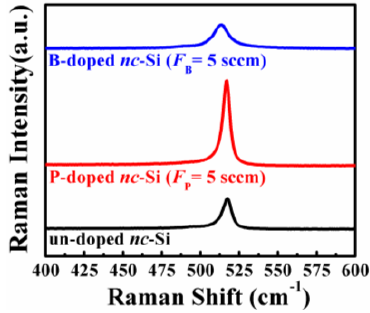
Figure 1. Raman spectra of un-doped nano-crystalline Si (nc-Si) film, P- and B-doped films with F P = F B = 5 sccm.